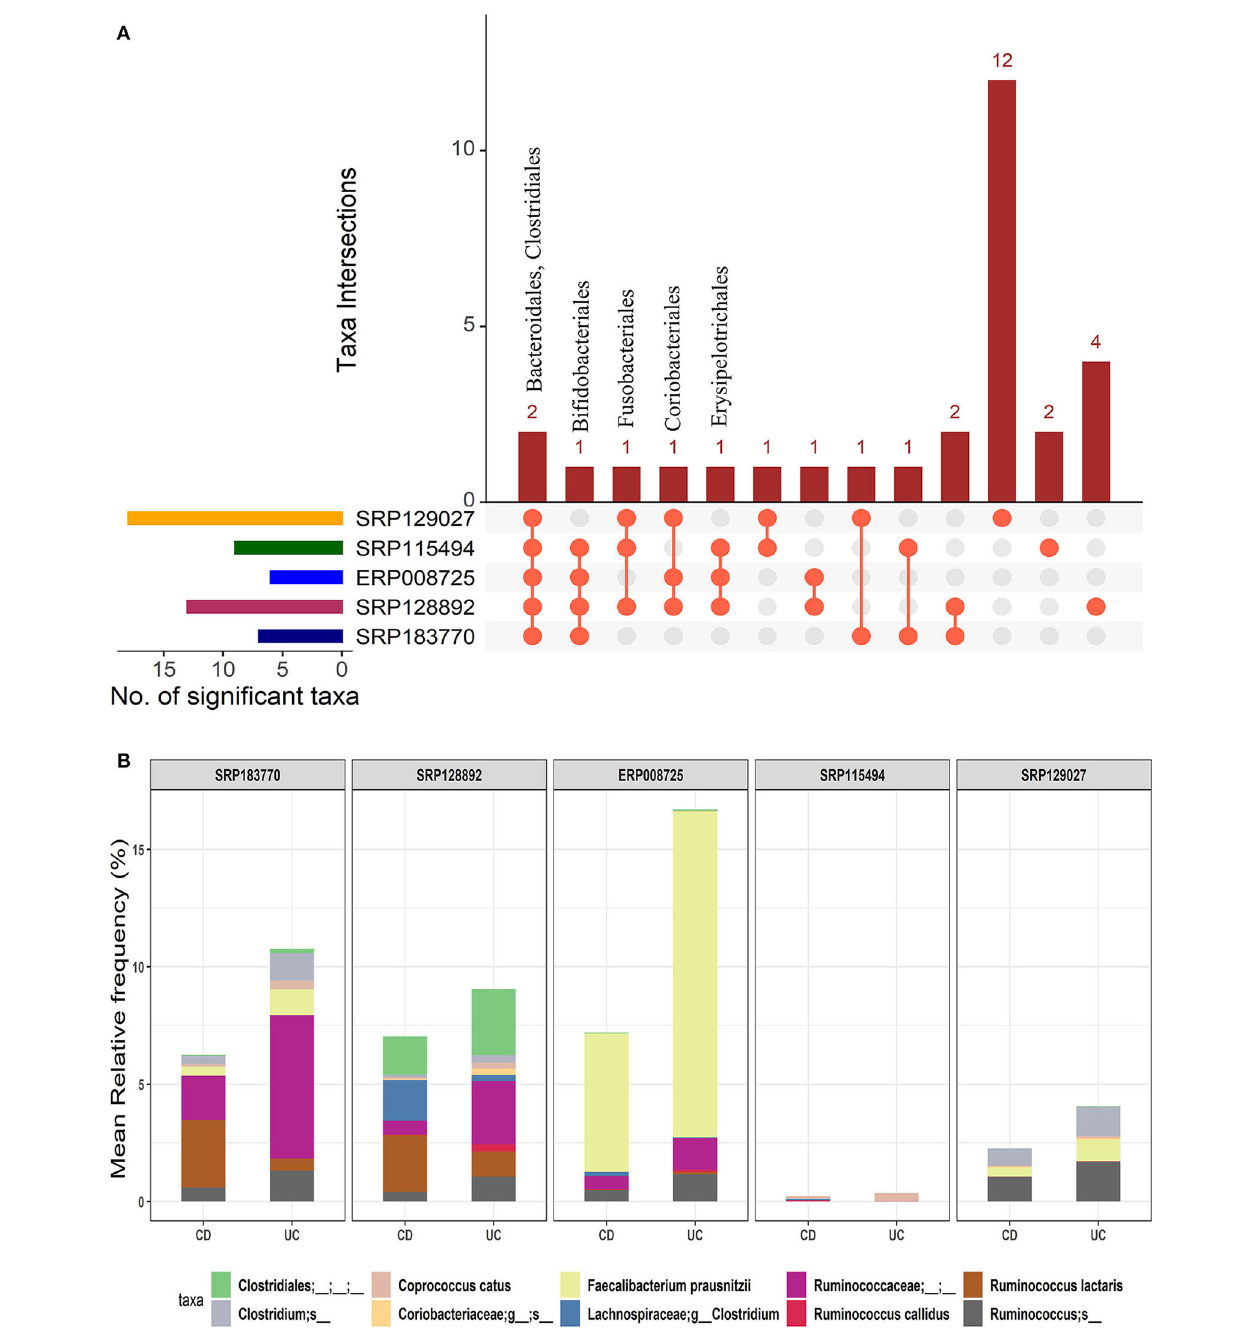
FIGURE 4 | Comparison of microbial communities between CD and UC cohorts across five datasets. (A) An upset plot showing taxonomic intersections across the five datasets at the Order-level. Each bar represents the number of orders in that category and the orange dot below the bar indicates their conservation across the datasets. For instance, members of Bacteroidales and Clostridiales are conserved in all five datasets; (B) Stacked bar plots show the relative mean frequencies of significant species-level communities in CD or UC that are present in at least in three out of five datasets. Corresponding values are provided in the 195 OTUs sheet in Supplementary Datasheet 5 , where the columns contain data for five different